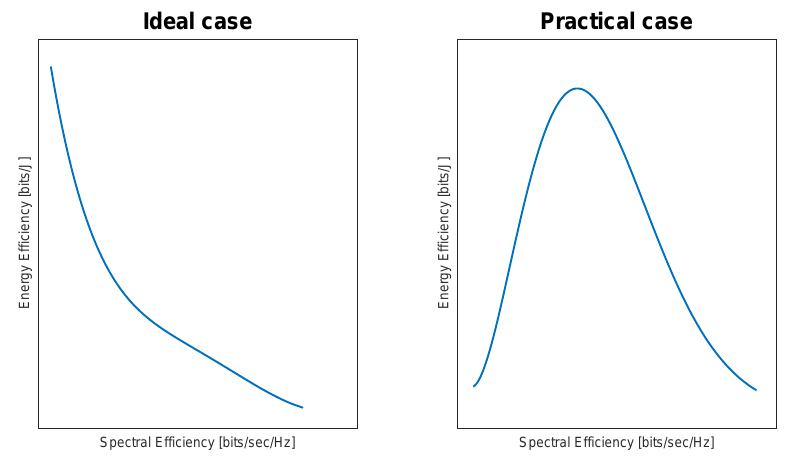
Figure 1. Ideal case and Practical